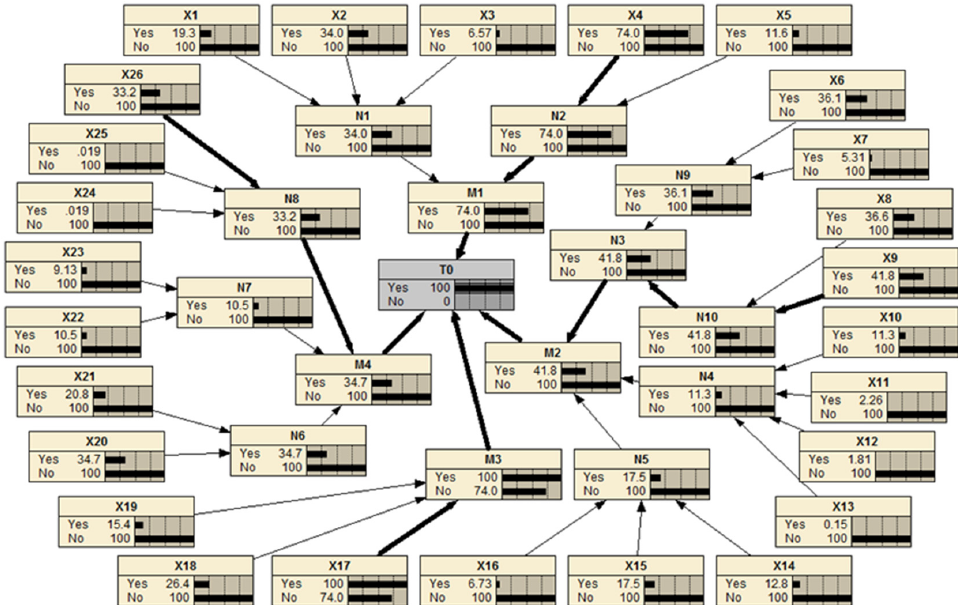
Figure 9. The MAP and MPE of CFIT accidents (The thick arrows represent the most likely paths).